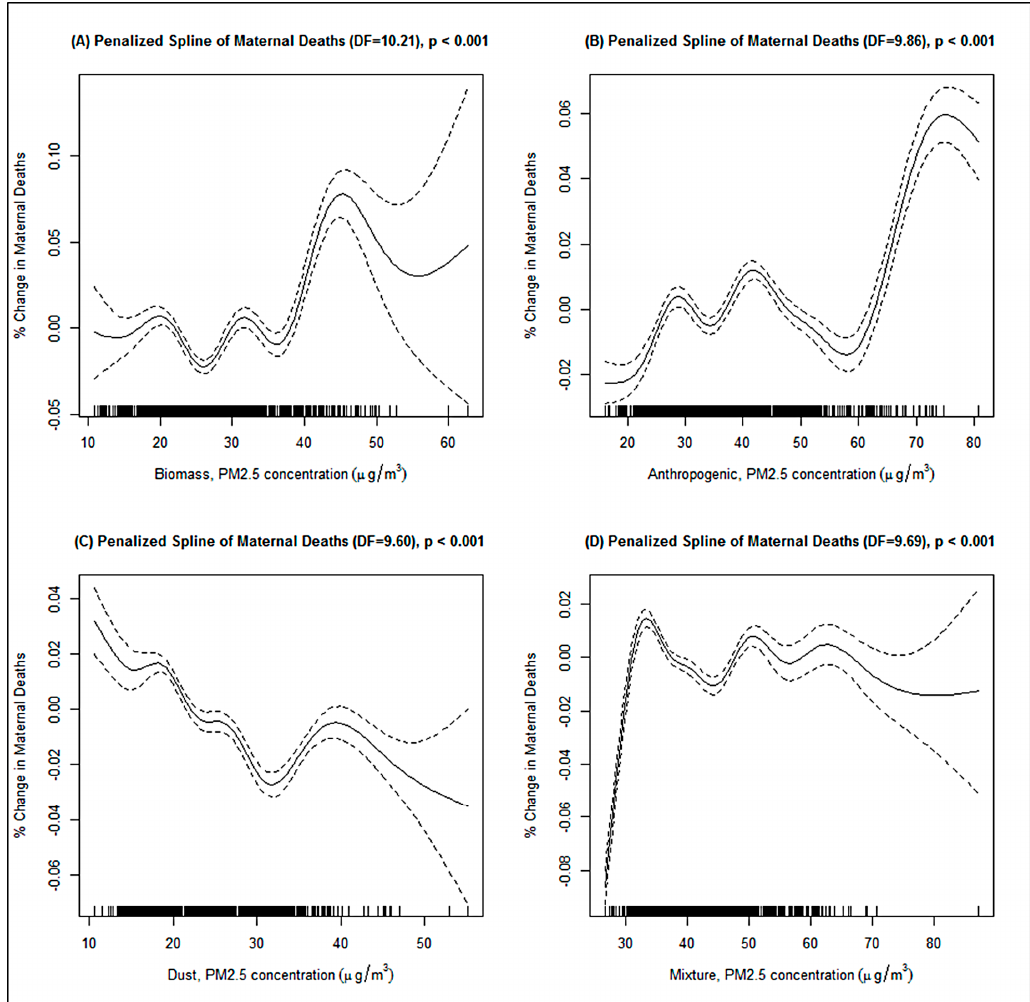
Figure 5. GAMM-estimated relationship between long-term PM 2.5 concentration and maternal mortality in Africa In terms of ( A ) Biomass, ( B ) anthropogenic, ( C ) dust, and ( D ) mixture PM 2.5 concentration. Adjusted for country, year, total population, urban population, female population, employed population, HIV/AIDS death, tuberculosis death rate, undernourished population, and temperature. The continuous line shows the dose-response relationship while the broken line corresponds to 95% confidence interval.